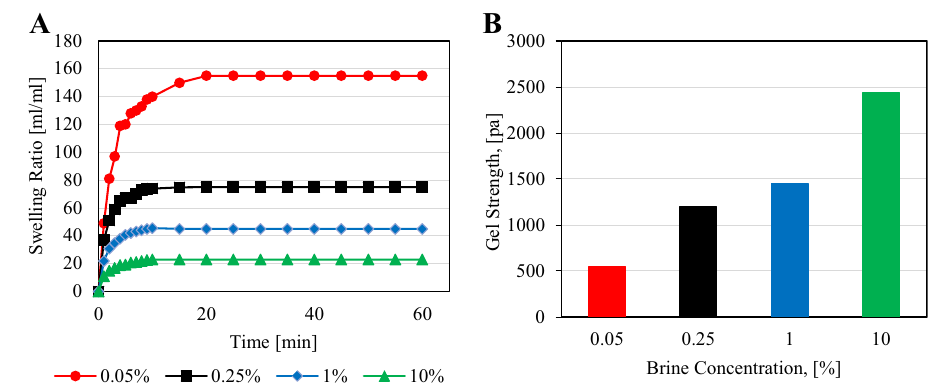
Fig. 2 Swelling ratio and gel strength of gel at different NaCl (by weight) concentrations